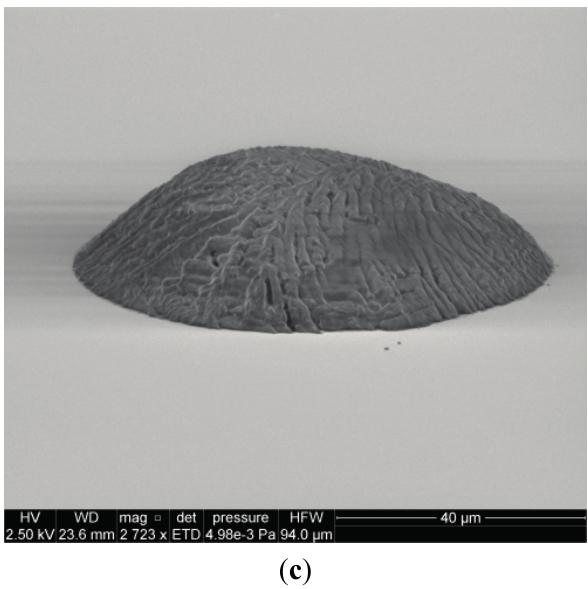
Figure 11. SEM images of RDX particles printed on the treated silicon surface. (note images are not at the same spatial scale). ( a )1 Drop, ≈ 12 μ m wide, 3 μ m high; ( b ) 10 Drops, ≈ 27 μ m wide, 7 μ m high; ( c ) 100 Drops, ≈ 55 μ m wide, 17.8 μ m